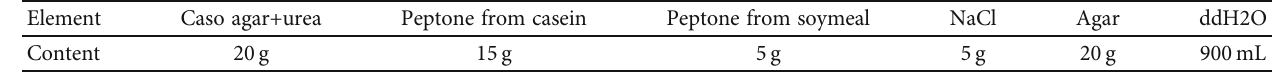
Table 2: Composition and content of medium per liter.